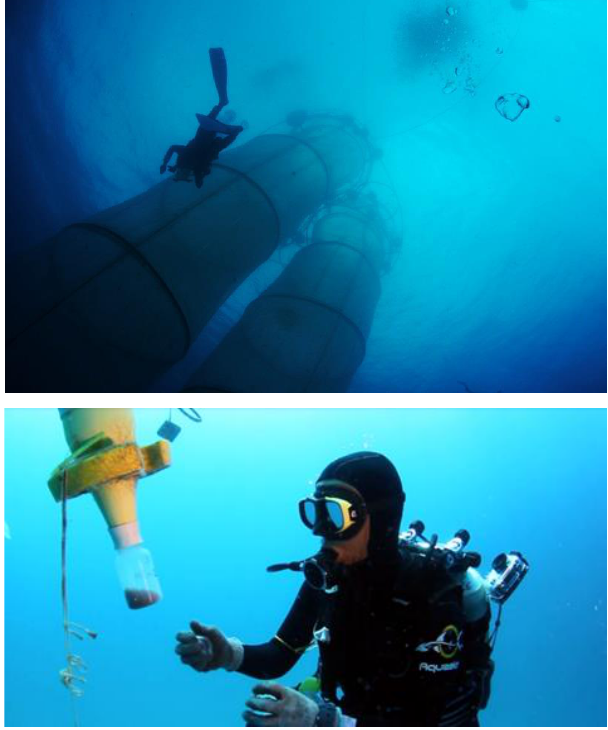
Figure 1. (a) Mesocosms ( ∼ 50m 3 ) deployed in the framework of the VAHINE project. (b) Sediment traps screwed onto the base of the mesocosms and were sampled daily by scuba